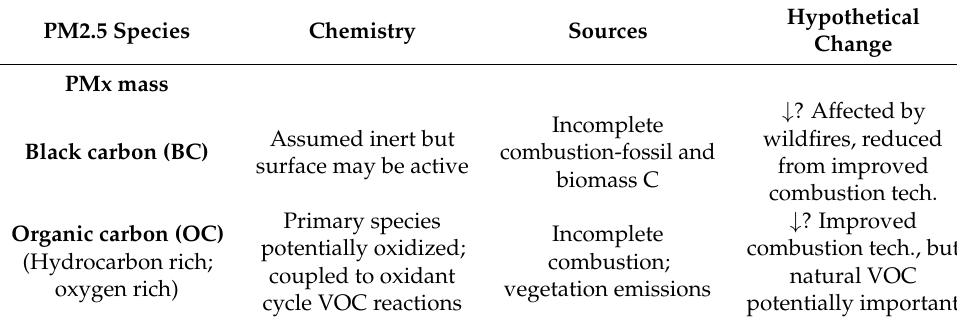
Table 2. Particle measures potentially associated with urban chemistry, including representatives of primary and secondary sources. Species in bold are routinely monitored. Particle nitrate requires special measurement because of its volatility as NH 4 NO 3